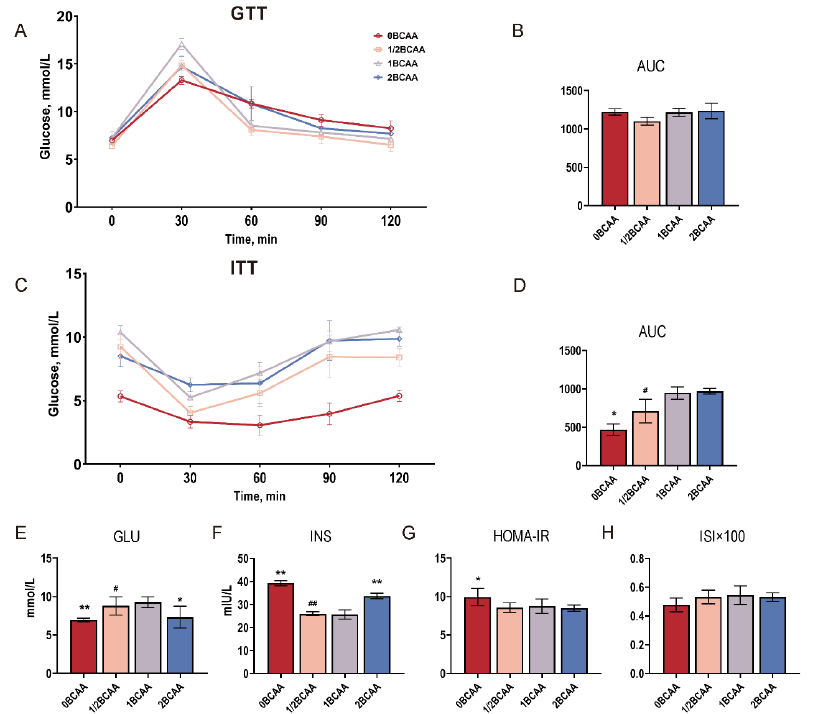
Figure 2. Effects of different dietary BCAA levels on glucose homeostasis in lean mice. ( A ): GTT curve; ( B ): GTT AUC; ( C ): ITT curve; ( D ): ITT AUC; ( E ): Serum GLU level; ( F ): Serum INS level; ( G ): HOMA-IR; ( H ): ISI index. Values are presented as the means ± SEM (n = 8). GTT: Glucose tolerance test; ITT: Insulin tolerance test; AUC: Areas under the curves; GLU: Glucose; INS: Insulin; HOMA- IR: Homeostasis model assessment of insulin resistance; ISI: Improved insulin sensitivity index. Val- ues are presented as the means ± SEM (n = 8). * p < 0.05, ** p < 0.01 versus 1BCAA group. # p < 0.05, ## p < 0.01 in 2BCAA group versus 1/2BCAA group.